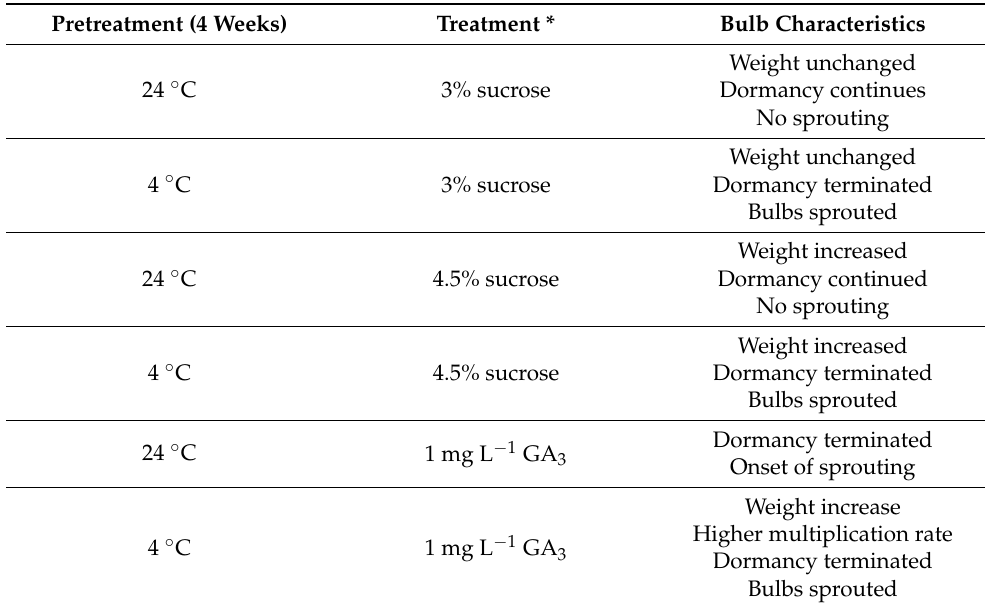
Table 3. Effect of pretreatment and nutrition medium composition on bulb weight, dormancy release and sprouting of F. meleagris bulbs